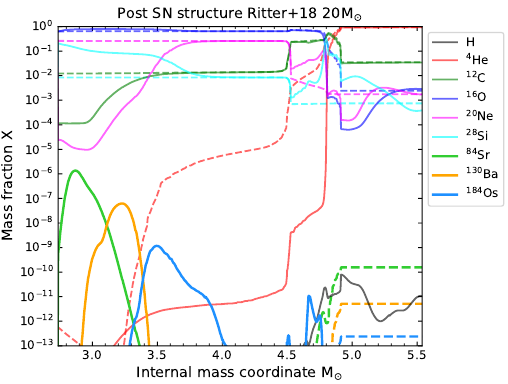
Figure 1. Abundance distribution before (dashed) and after (solid) the CCSN explosion in a 20 M ⊙ at Z = 0.02 [14]. The p –nuclei 84 Sr, 130 Ba and 184 Os are taken as representative for the γ –process nucle-